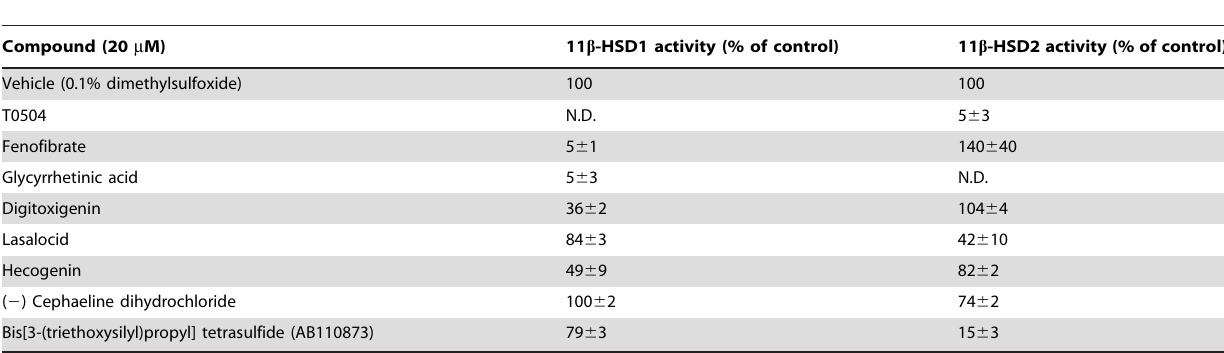
Table 1. Inhibition of 11 b -HSD1 and 11 b -HSD2 by compounds predicted by virtual screening.